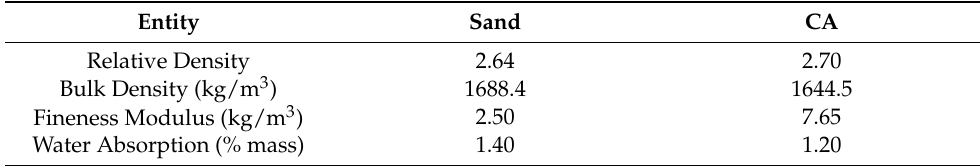
Table 5. The physical properties of CA and sand. Entity